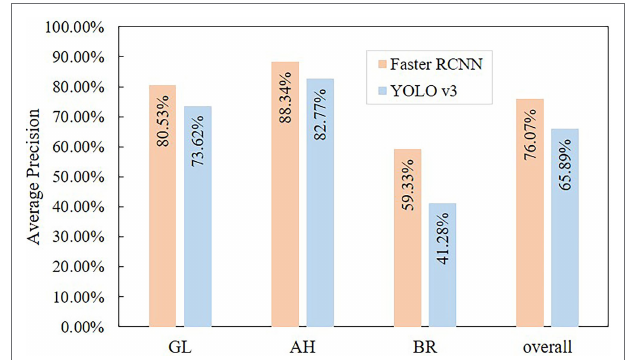
FIGURE 6 | The accuracy of the object detection algorithm.